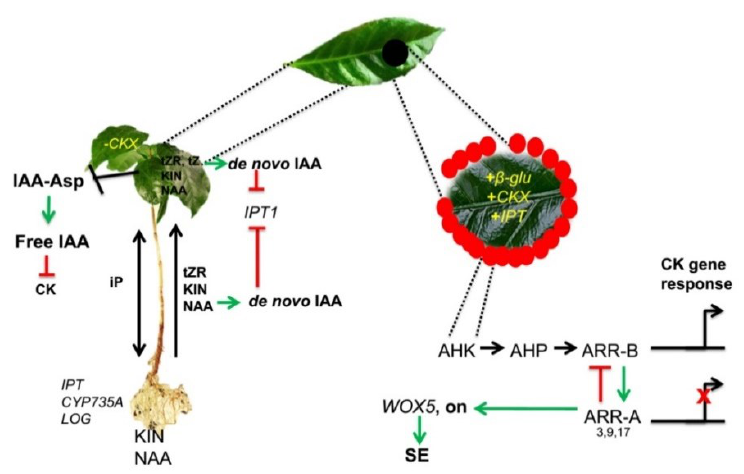
Figure 9. Proposed CK homeostasis model during somatic embryogenesis of C. canephora . NAA and KIN are transported into the leaves. KIN probably are acropetally transported by an ENT transporter using the xylem. NAA can induce de novo Aux biosynthesis; tZR and tZ are synthesized in the roots and transported to the aerial part, while iP is synthesized in the roots and aerial part. The tZ can induce de novo Aux biosynthesis as well. This leads to IPT1 repression. NAA probably represses CKX genes, increasing the CK content in the plantlets. It has been demonstrated that CK can be compartmentalized in vacuoles in their conjugated form. BA (red circles) induces the expression of CKX and IPT genes. BA induces β -GLUCOSIDASE genes; hence β -glucosidase breaks the glycosidic bond and releases the free CK. The degradation products of KIN can be used to synthesize other CK. BA may activate the phosphorelay signaling system, leading to transcription of CK-related genes by ARR Type B or repression of CK-related genes by ARR Type A. ARR Type A can downregulate Aux repressing PIN1 genes through SHY2/IAA3 induction. However, CK can induce de novo synthesis, inhibiting the IAA conjugation with aspartic amino